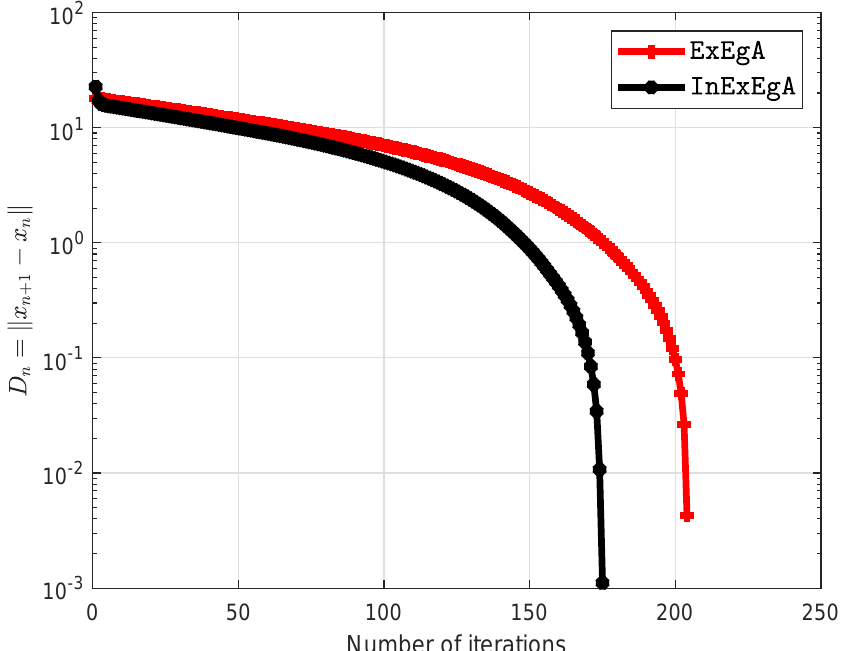
Figure 5. Algorithm 1 comparison with Algorithm 1 in [16] and number of iterations are 204 and 175